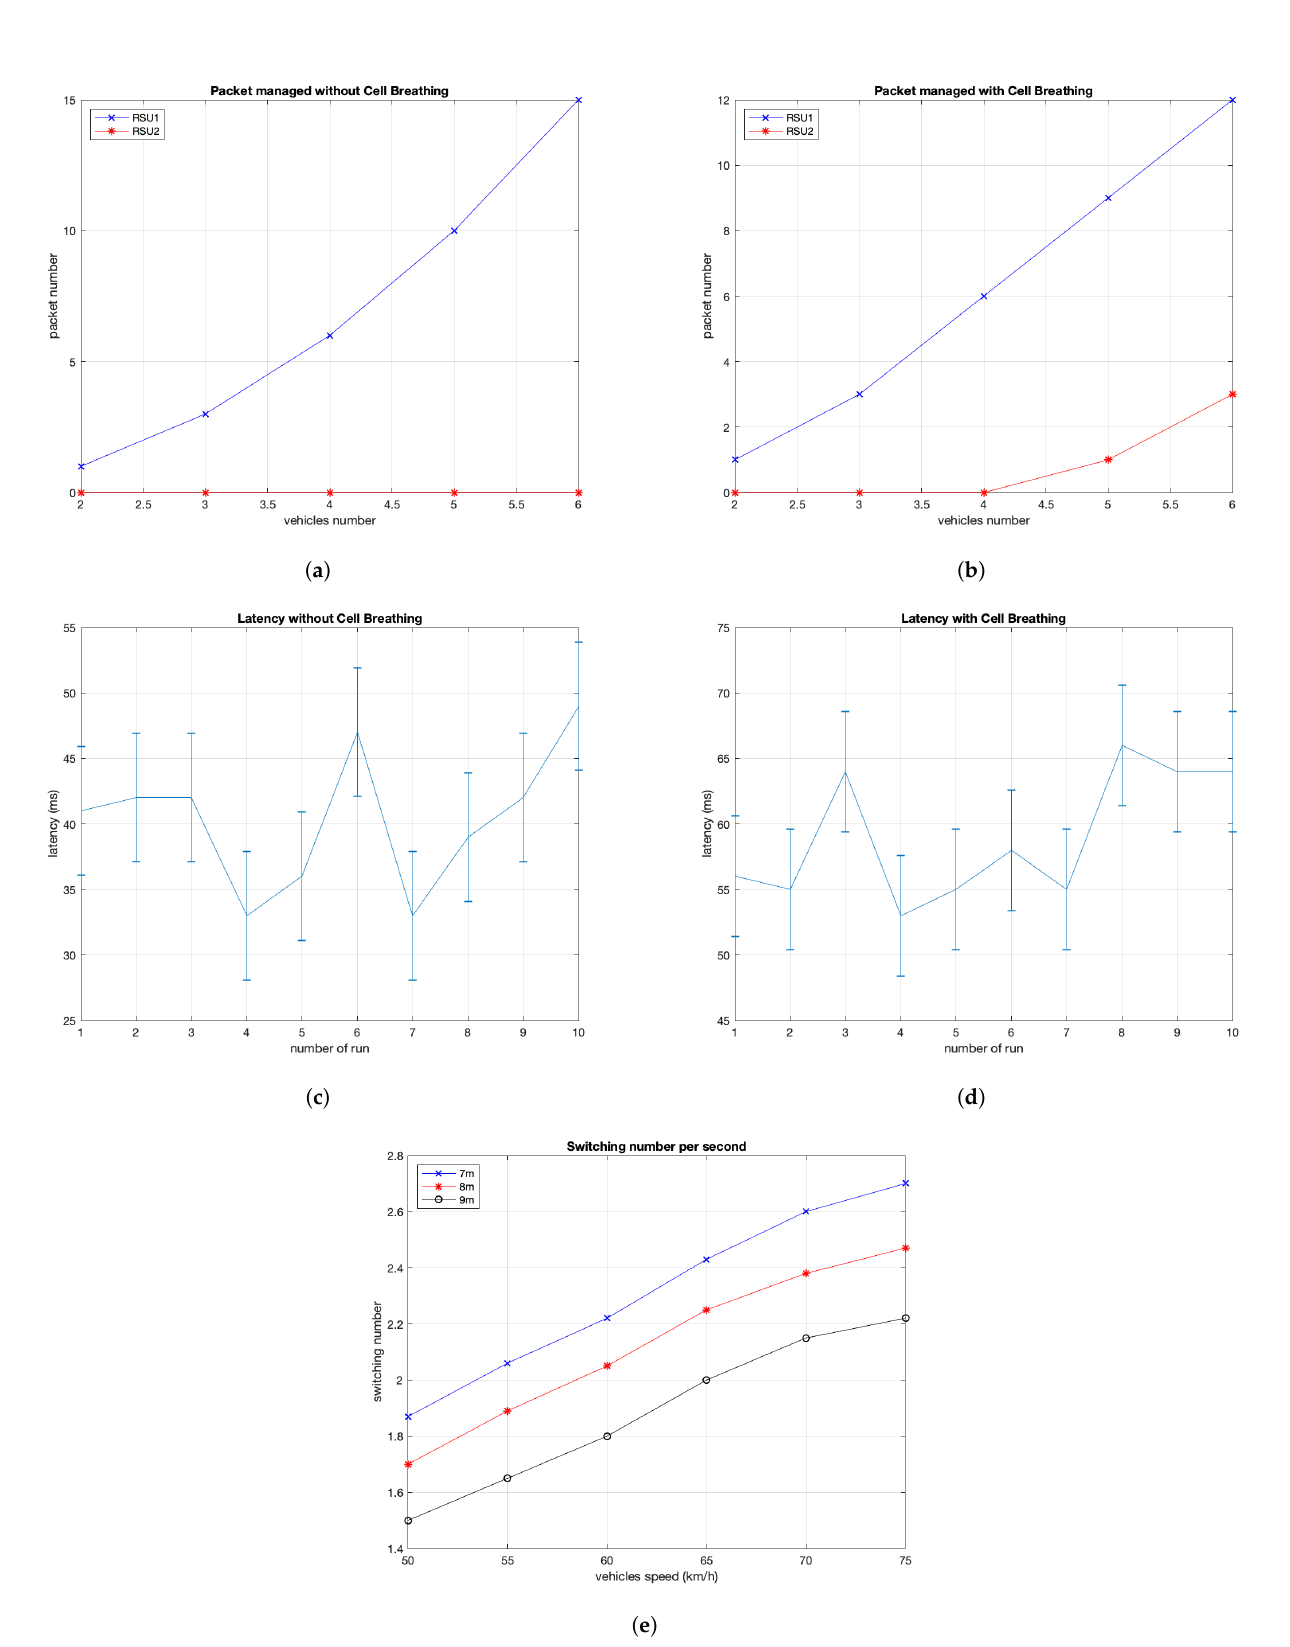
Figure 8. ( a )Packets managed without cell breathing technique; ( b ) packets managed with cell breathing technique; ( c ) latency without cell breathing technique; ( d ) latency with cell breathing technique; and ( e ) switching per time